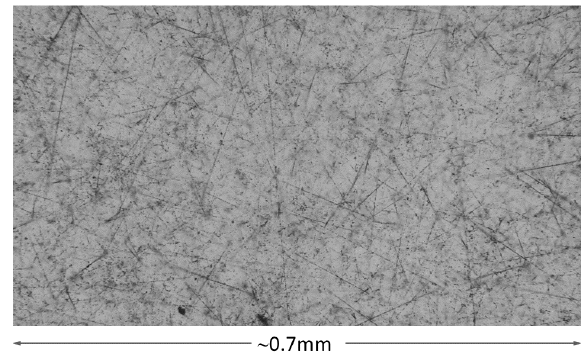
Fig 1. Microscope image of tracks of charged particles recorded in an emulsion plate of the RUNJOB